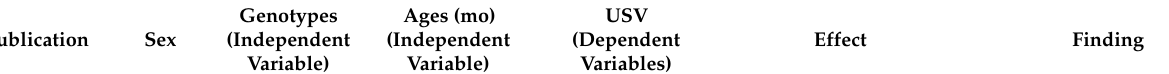
Table 3. Summary of interaction effects and main effects of genotype and age on USV production between DJ1-/- rats and WT